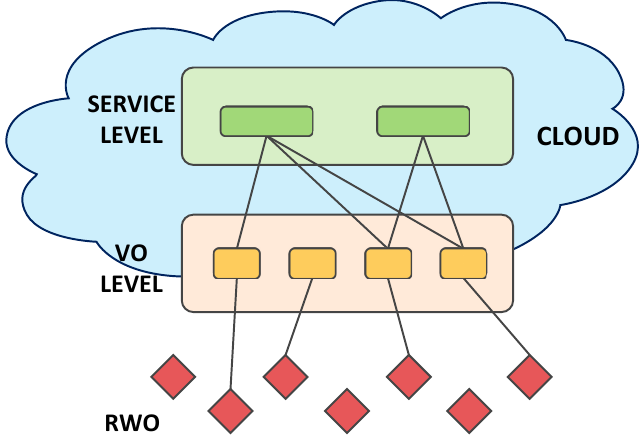
Figure 1. The reference IoT cloud